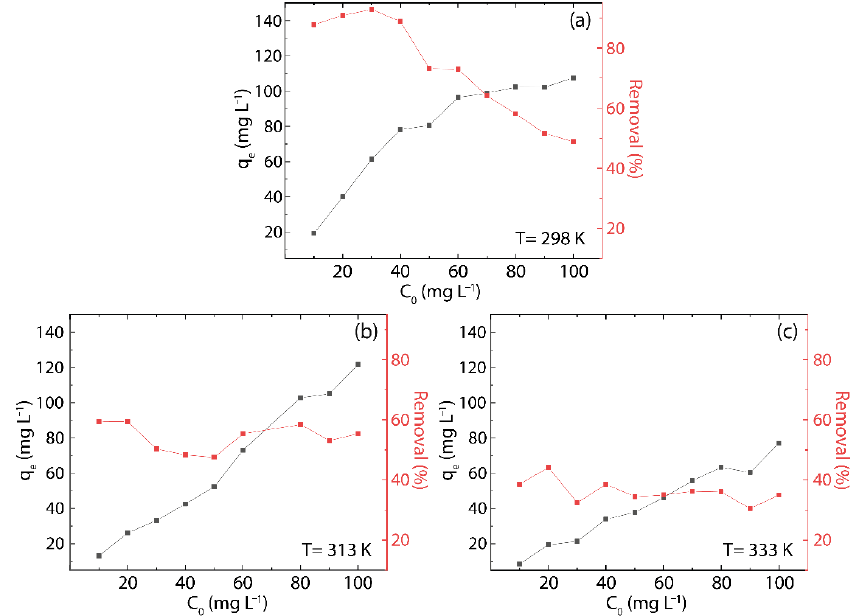
Figure 9. Adsorption capacity (black points) and removal percentage (red points) as a function of C 0 𝐶 0 at ( a ) 298 K, ( b ) 313 K, and ( c ) 333 K.